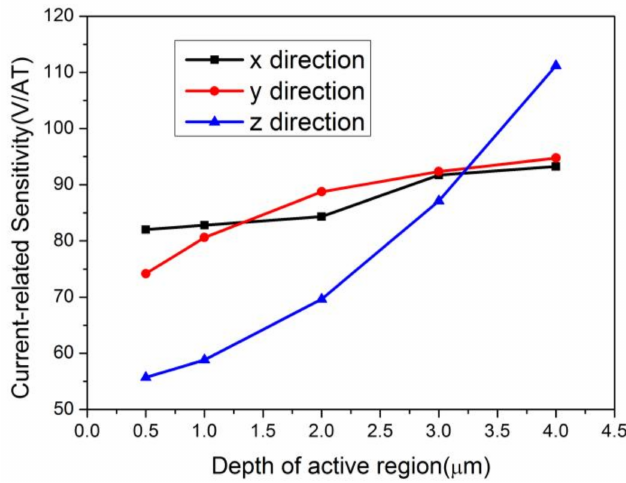
Figure 15. Relationships between the current-related sensitivities in three directions and the P-type layers’ depth. The depth of the active region is 7 µ m.